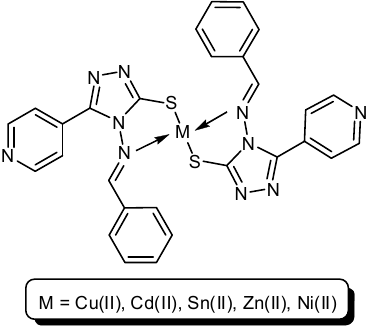
Figure 1. Structure of metal complexes (ML 2 ).